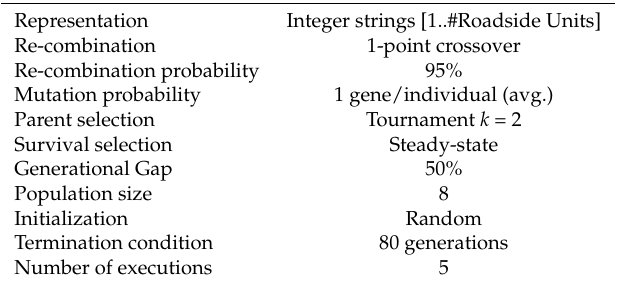
Table 1. Parameters used in our genetic algorithm approach.